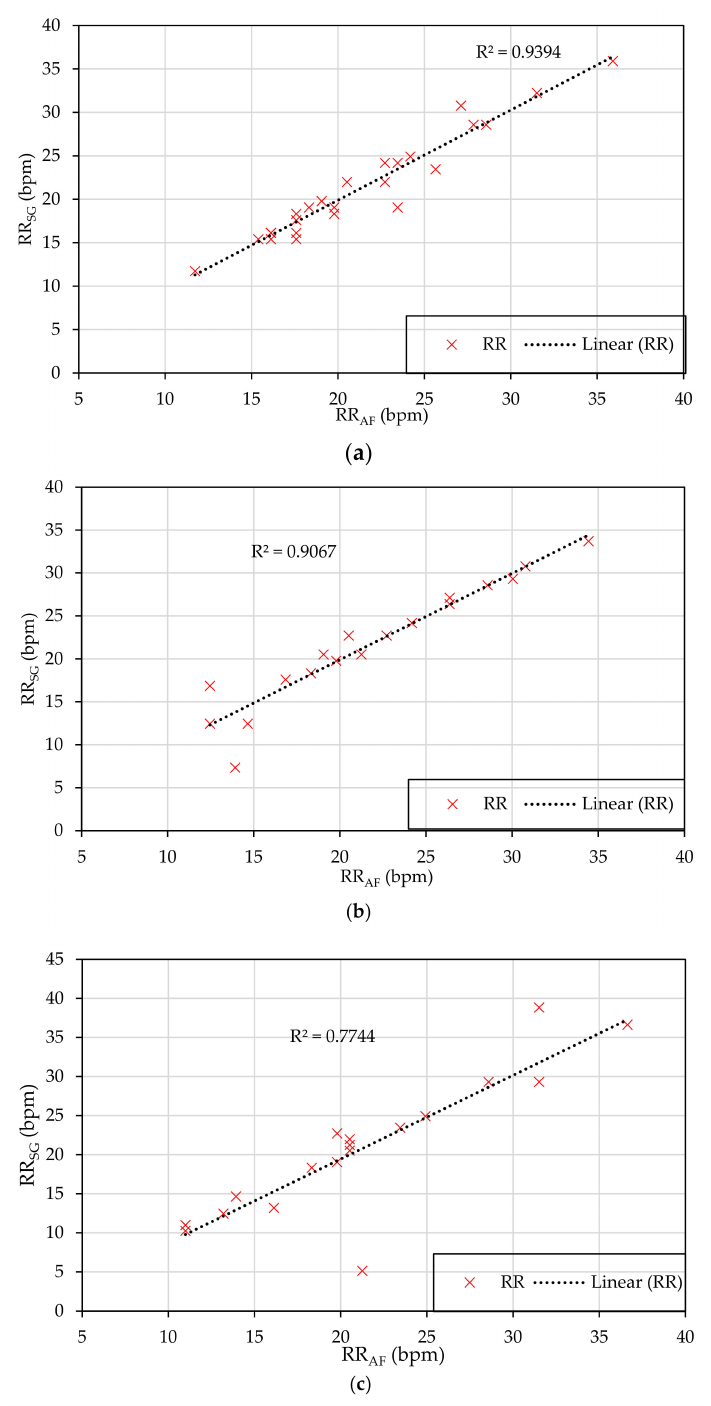
Figure 5. Linear regression analysis of the measured respiratory rate of the COPD patients at different postures namely at: ( a ) Sitting, ( b ) standing, and ( c ) lying45 ◦